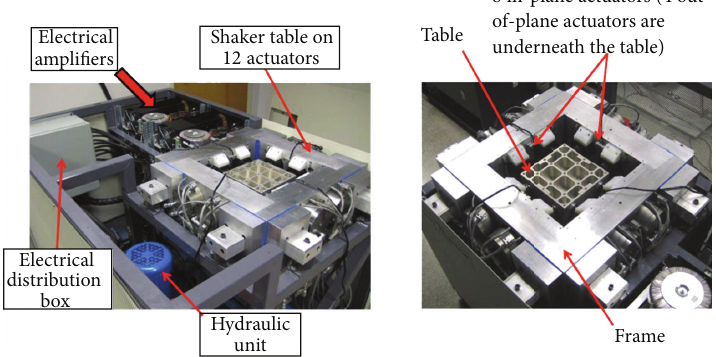
Figure 1: Six-DoF electrodynamic shaker at CALCE (with TEAM Inc.